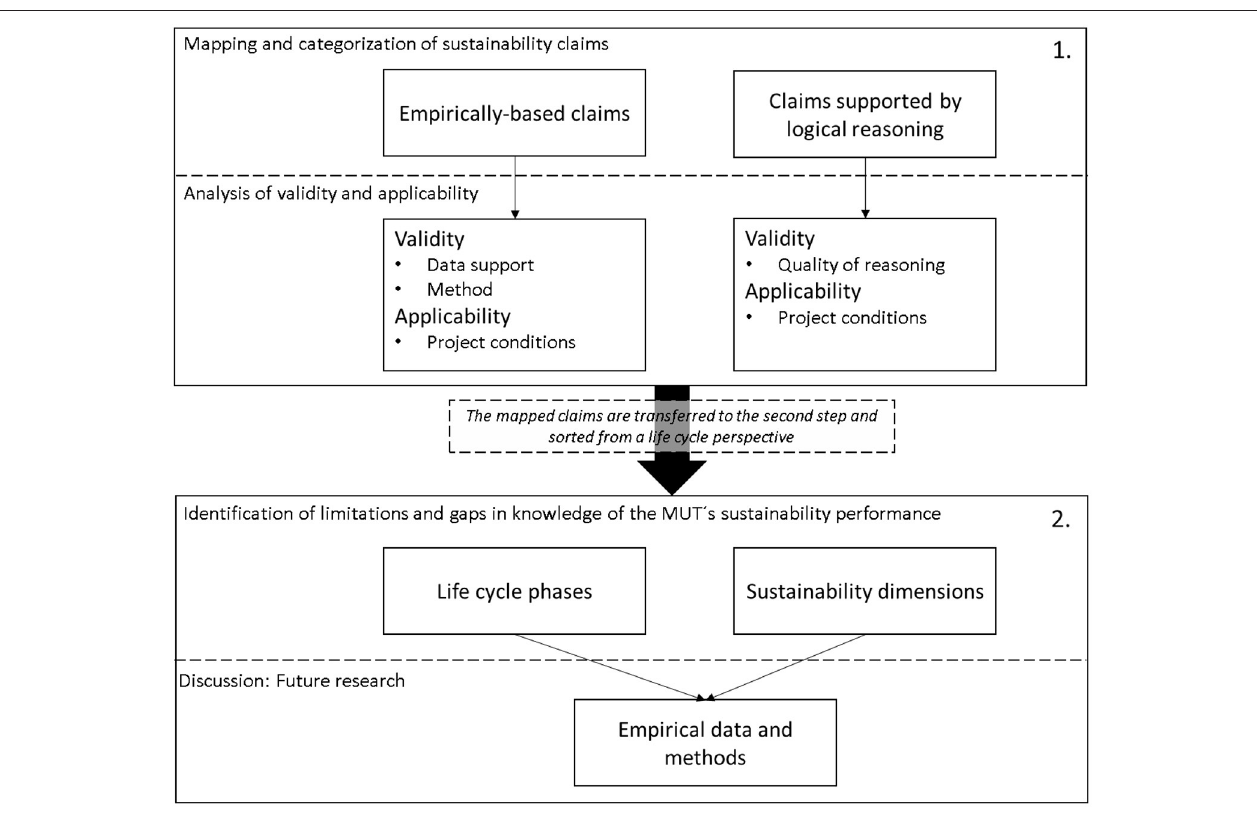
FIGURE 2 | Scheme for the analytical approach of the review. The analysis consisted of two steps, where the first (1) focused on the validity and applicability of identified claims in the articles, and the second (2) on which life cycle phases and sustainability dimensions the previous claims addressed.